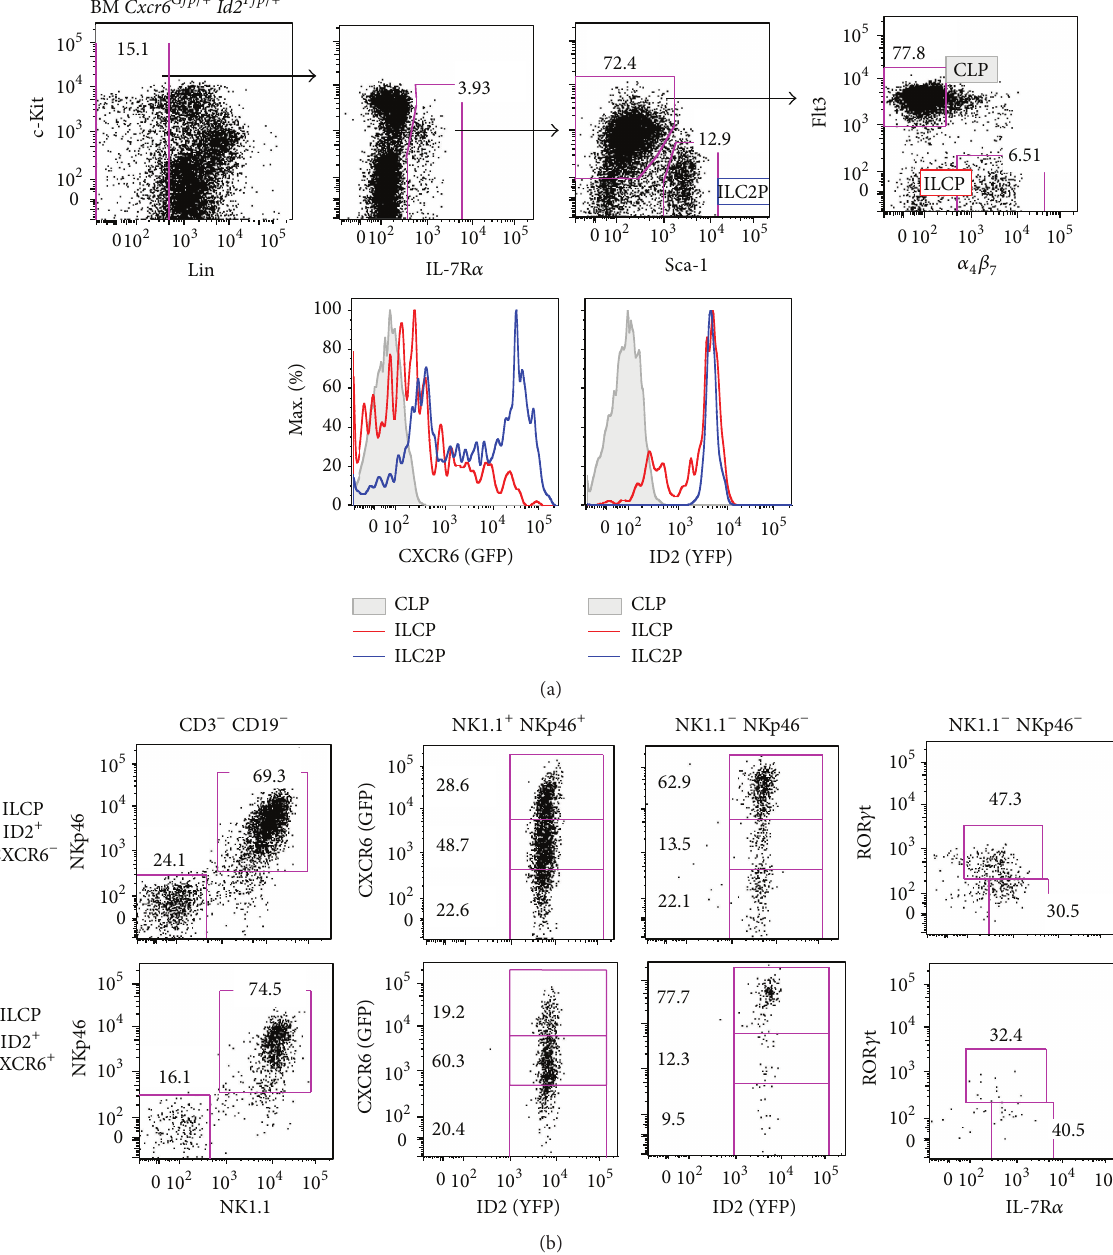
Figure 1: ILCP and ILC2P in the bone marrow heterogeneously express CXCR6. (a) Flow cytometry of lineage depleted (Lin: CD3 𝜀 , CD5, CD8, CD11c, CD19, TCR 𝛽 , TCR 𝛾𝛿 , Ter119, Gr1, and NK1.1) adult bone marrow (BM) from Cxcr6 Gfp/+ Id2 Yfp/+ mice. Among Lin − IL- 7R 𝛼 + compartments are defined: CLP (filled gray, c-Kit lo Sca- 1 −/ lo Flt3 + 𝛼 4 𝛽 7− ), ILCP (red, c-Kit lo Sca- 1 −/ lo Flt3 − 𝛼 4 𝛽 7+ ), and ILC2P (blue, c-Kit − Sca- 1 hi ). Each compartment is analyzed for CXCR6-GFP and ID2-YFP expression (bottom histograms). (b) Cell culture of BM ILCP, selected as ID2 + CXCR6 − (upper panels) or ID2 + CXCR6 + (lower panels). Each population is sorted and cultured at 20 cells per well on OP9- DL4 stromal cells with IL-7, c-KitL, and Flt3L for 10 days and analyzed by flow cytometry. Indicated obtained progenies were analyzed for ID2-YFP, CXCR6-GFP, ROR 𝛾 t, and IL-7R 𝛼 expression. Results are representative of at least 3 experiments each ((a): 𝑛 > 5 ), or 2 experiments ((b), at least 4 wells of each